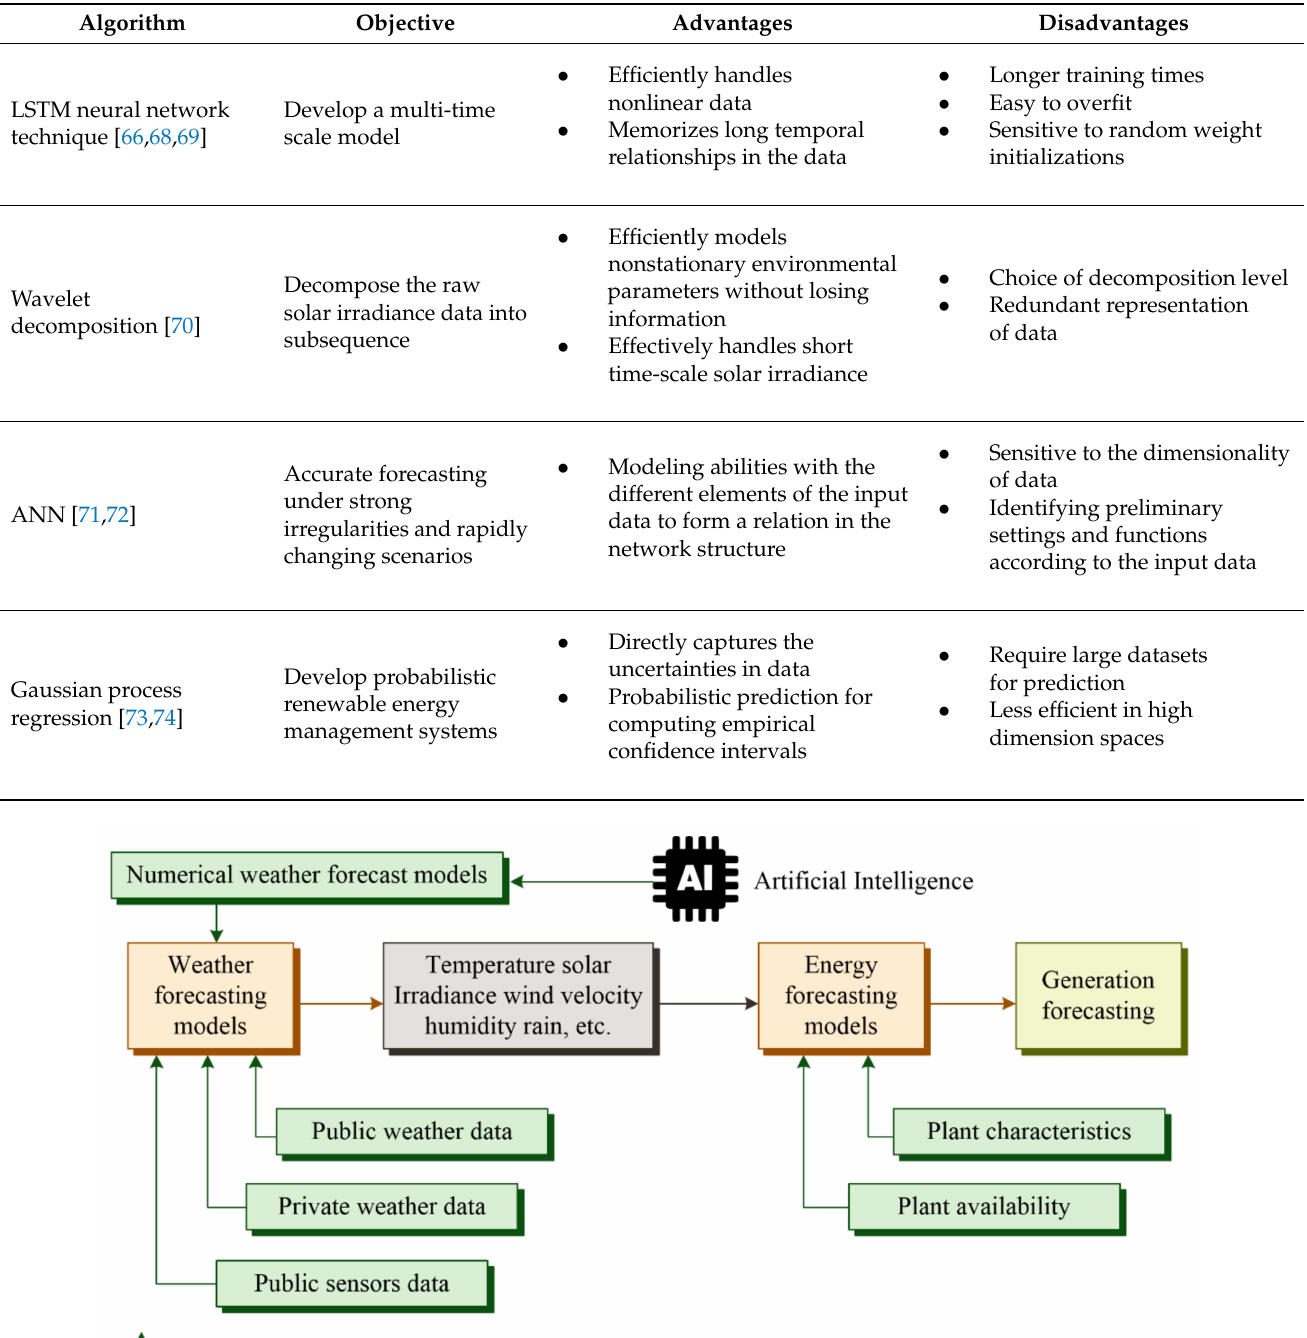
Table 4. Conventional and intelligent methods for solar irradiance forecasting.